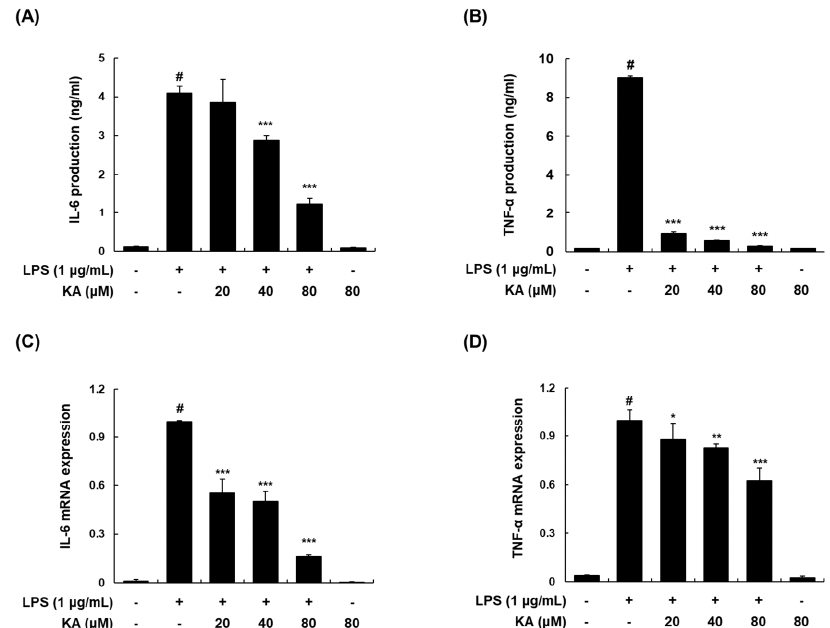
Figure 2. Effects of KA on the LPS-induced production and mRNA expression of interleukin (IL)-6 and tumor necrosis factor- α (TNF- α ) in RAW 264.7 macrophages. ( A , B ) Cells were pretreated